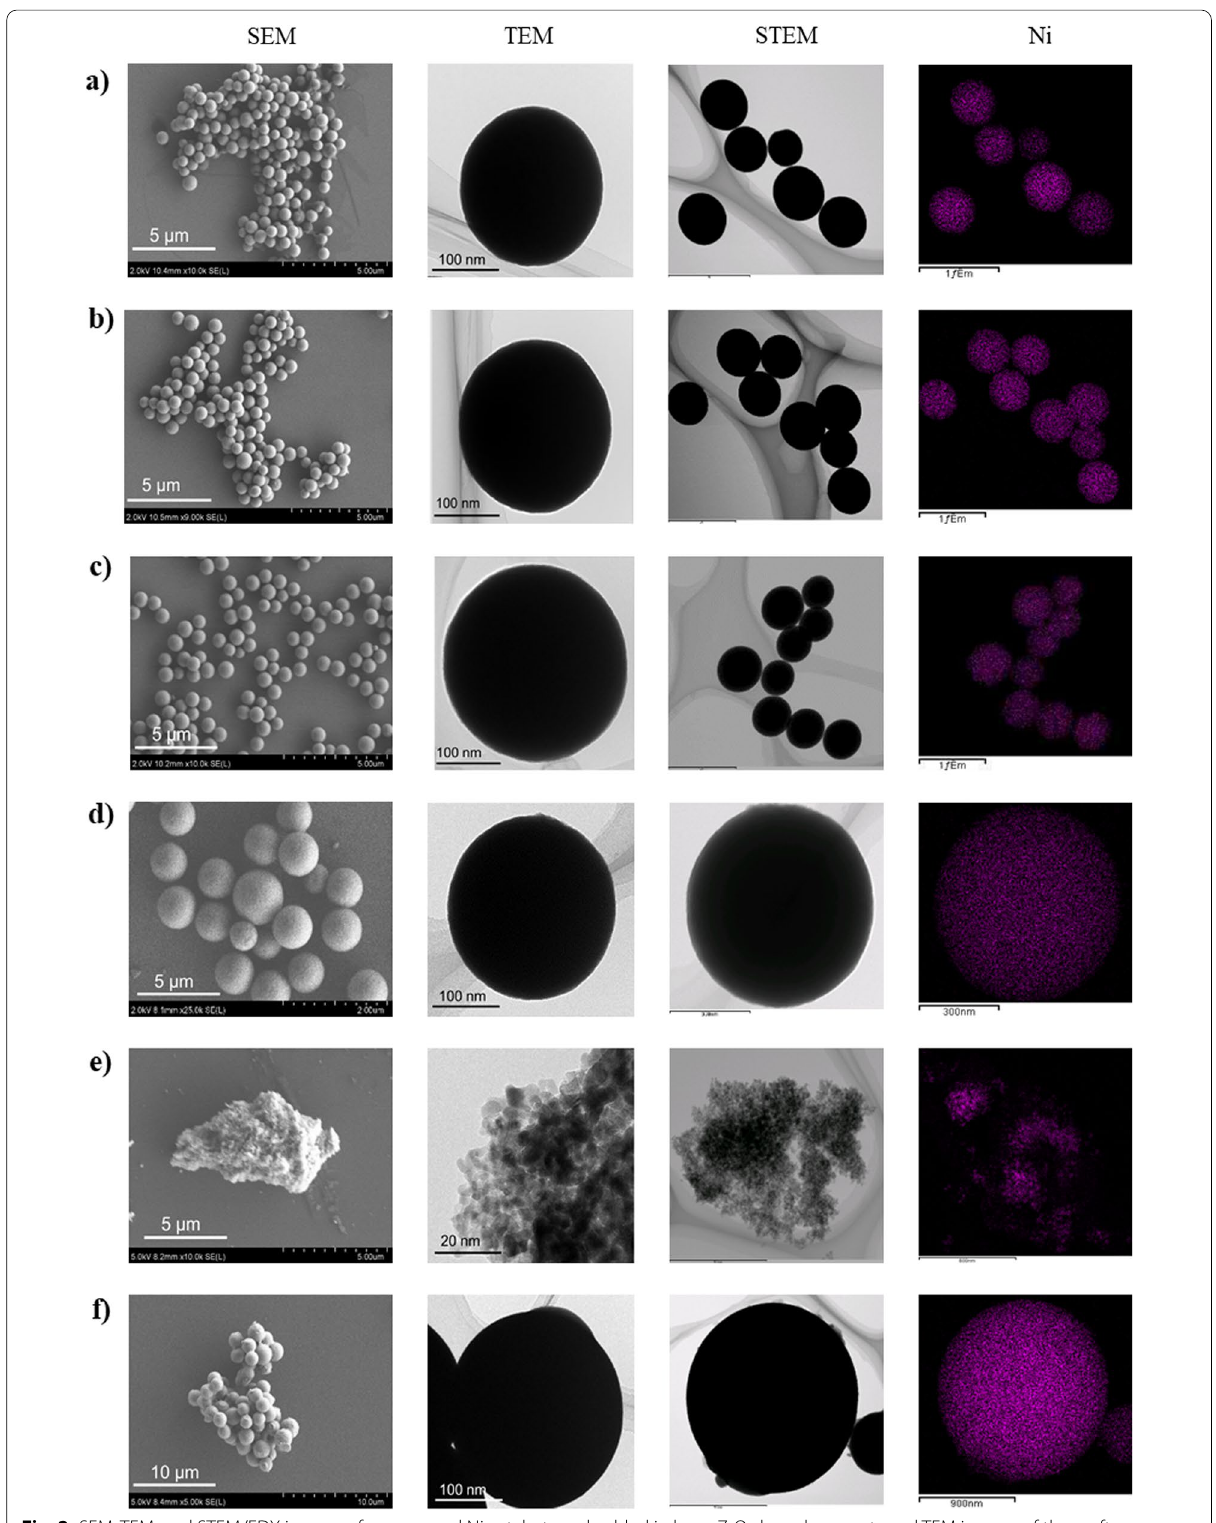
Fig. 2 SEM, TEM, and STEM/EDX images of as-prepared Ni catalysts embedded in large ZrO 2 -based supports and TEM images of them after hydrogen reduction: a L